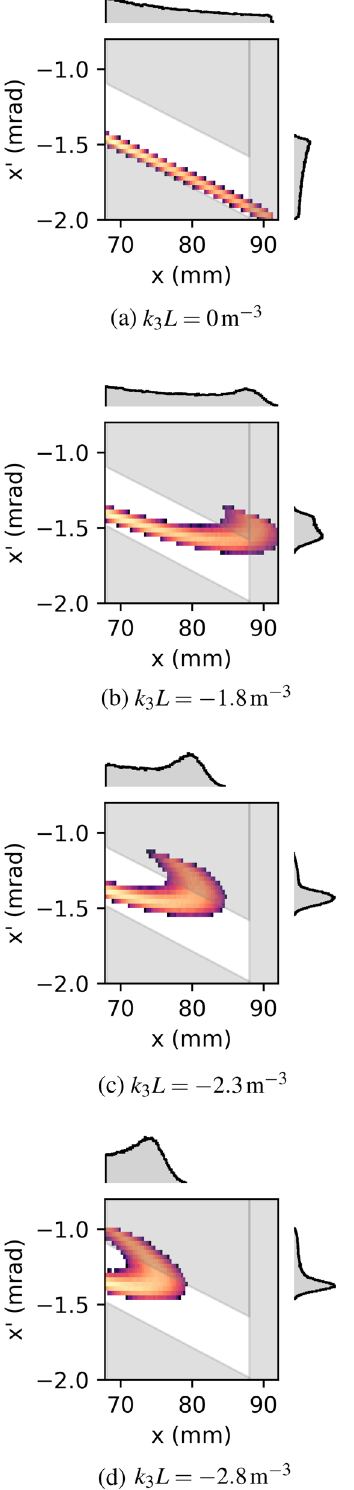
FIG. 9. Extracted beam in phase space on the high-field side upstream of the ZS simulated as a function of octupole strength with 2.1 times the nominal LSE strength, i.e., k 2 ¼ 2 . 1 k 2 nominal extraction bump amplitude. Color map is proportional to the particle density in phase space.